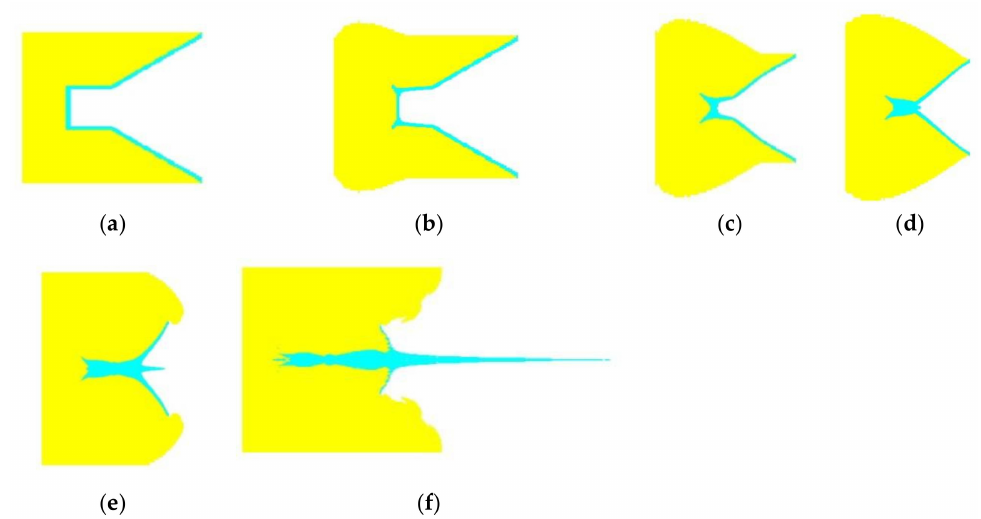
Figure 3. The formation process of the projectile formed by the cylinder-cone-shaped charge with a cylindrical copper liner. ( a ) t = 0 µ s. ( b ) t = 7 µ s. ( c ) t = 11 µ s. ( d ) t = 14 µ s. ( e ) t = 20 µ s. ( f ) t = 55 µ